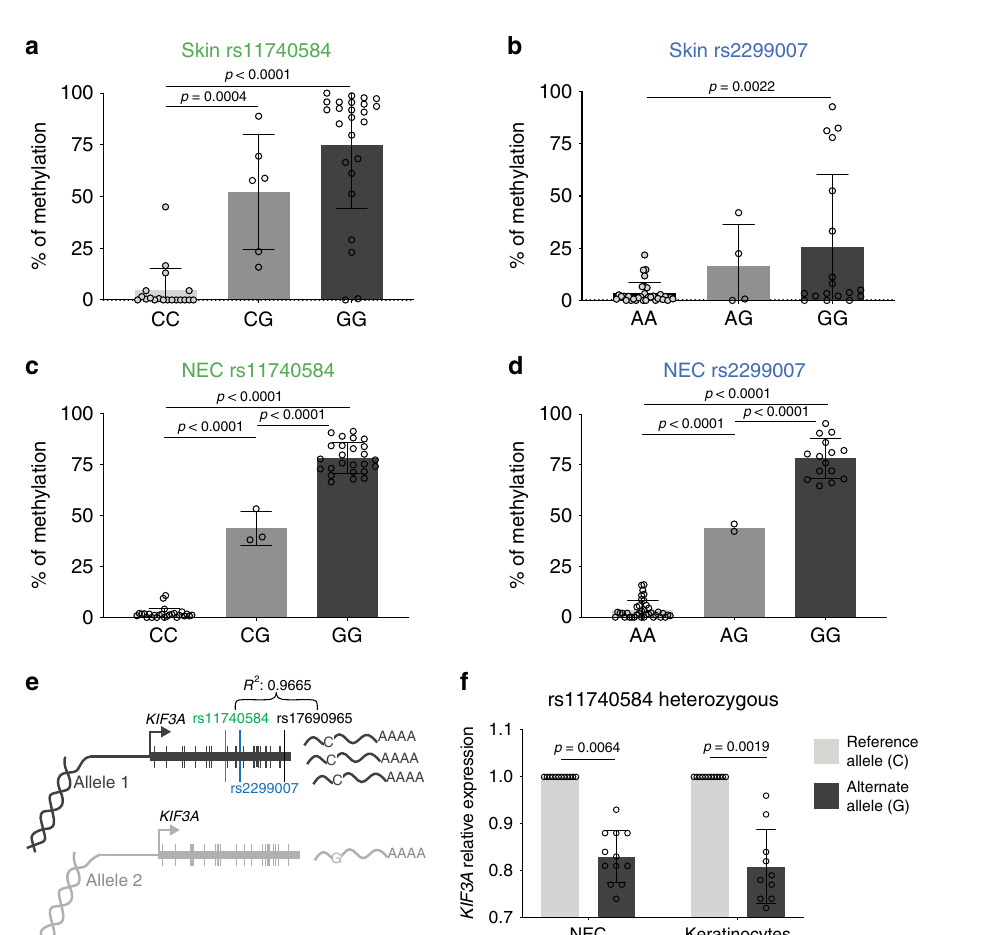
Fig. 2 rs11740584 and rs2299007 minor allele creates methylated CpG sites and alter KIF3A expression. Skin tape ( a , b ), and nasal epithelial cell ( c , d ), methylation levels at rs11740584 and rs2299007 CpG sites in homozygous and heterozygous alternate allele carriers. A one-way ANOVA was